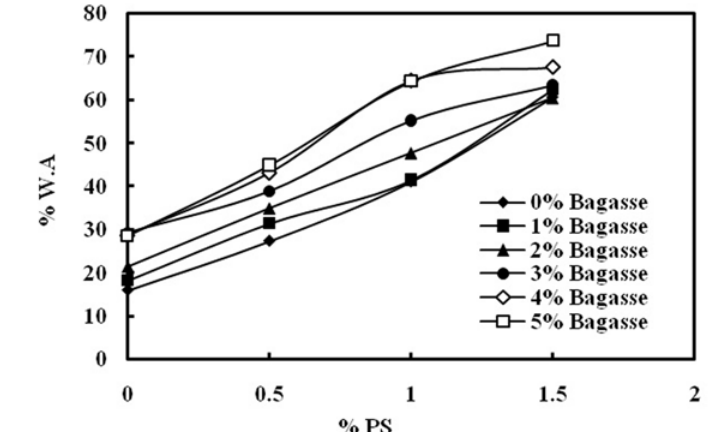
Figure 7. Effect of percent PS andBagasse addition to percent Water Absorption